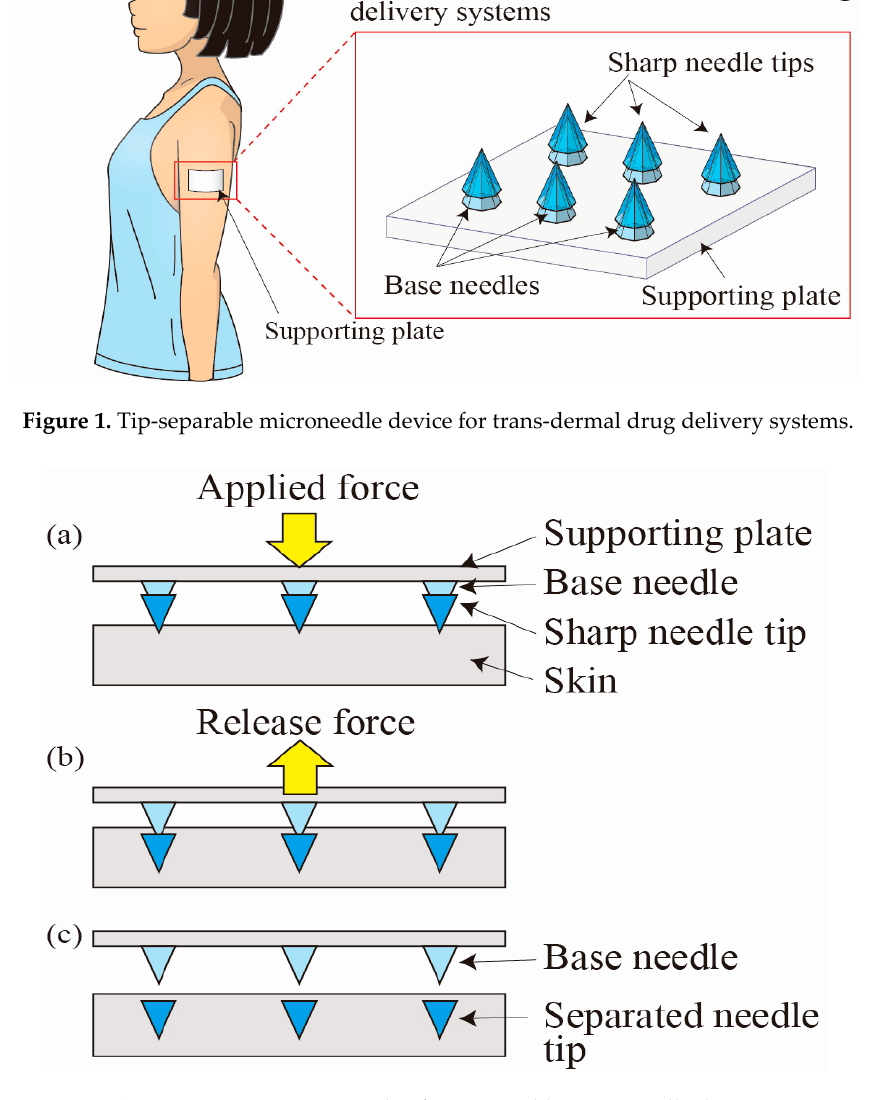
Figure 2. Operation principle of tip-separable microneedle